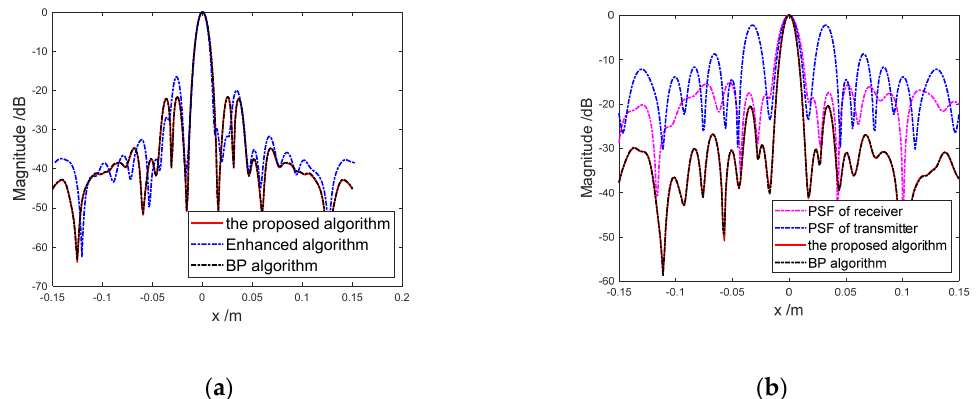
Figure 6. PSFs of different algorithms: ( a ) PSFs of different algorithms for ARRAY A; ( b ) PSFs of receiver, transmitter and different algorithms for ARRAY B.